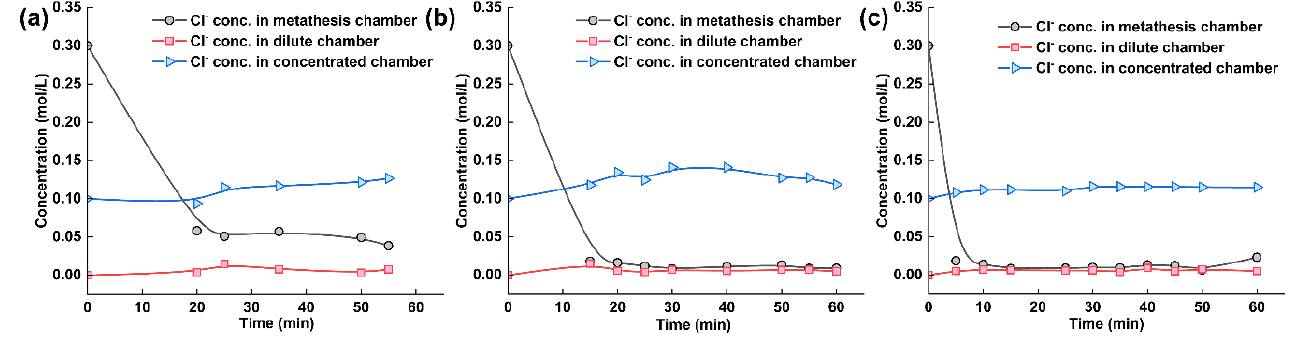
Figure 8. ( a ) Experimental results of tobacco liquor with ACS membrane, ( b ) with A-3 membrane, and ( c ) with TW-A membrane.